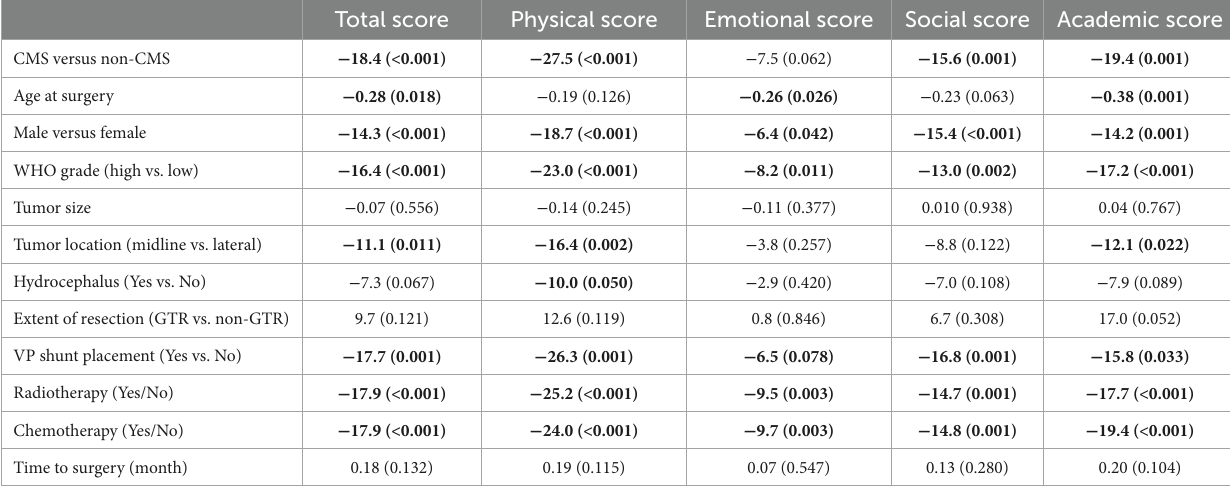
TABLE 5 Association of QOL and clinical variables.